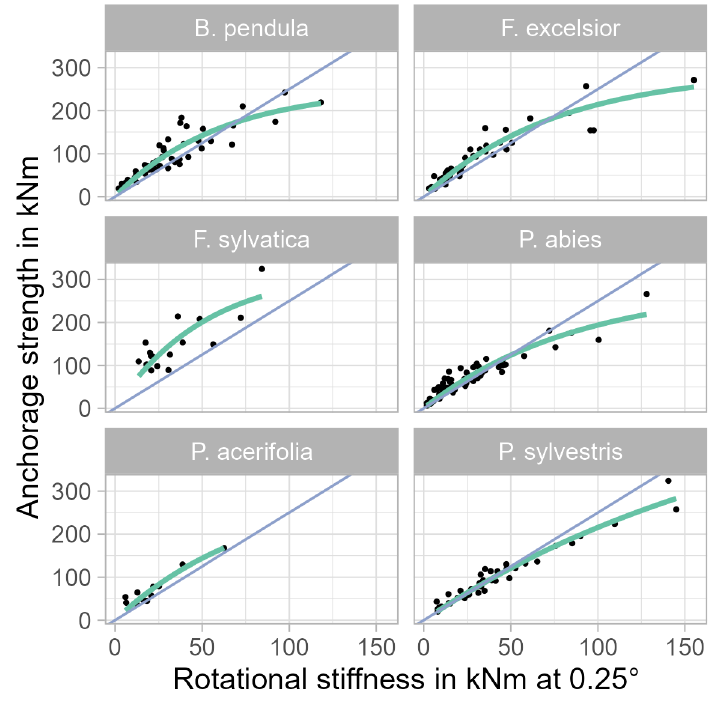
Figure 3. The relationship between rotational stiffness and anchorage strength varied from linear to curved depending on species. The blue line illustrates Equation (1) (fitted lines: M a = y 0 ( 1 − e − ak r ) , ANOVA: Table A2).